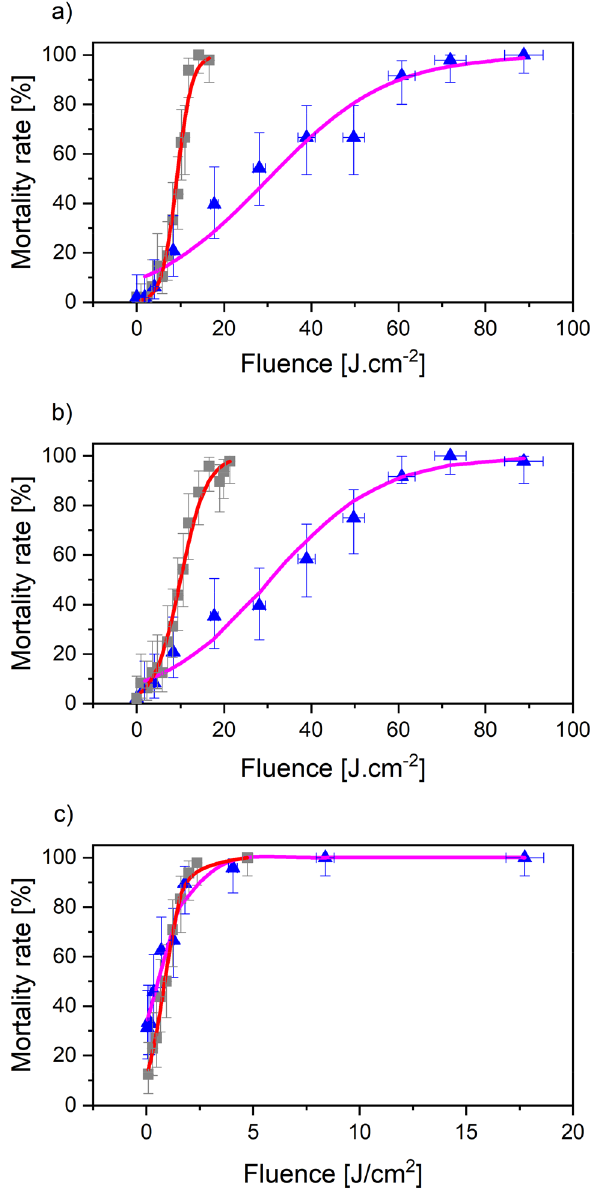
Figure 2. Mortality rates as a function of the fluence for 532 nm and 10.6 µm lasers at Day + 1. Error bars are plus and minus exact binomial 95% confidence intervals. Control samples showed that 96% or more aphids survived. ( a ) A. pisum LL01 (green aphids). ( b ) A. pisum YR2 (pink aphids). ( c ) R. padi (dark-green aphids). Blue dots and Gray squares refer to experiments done using the 532 nm and 10.6 µm lasers respectively. The purple and red solid lines are logistic regressions to the data obtained with the 532 nm and 10.6 µm lasers respectively. Statistical tests are available in Supplementary Table